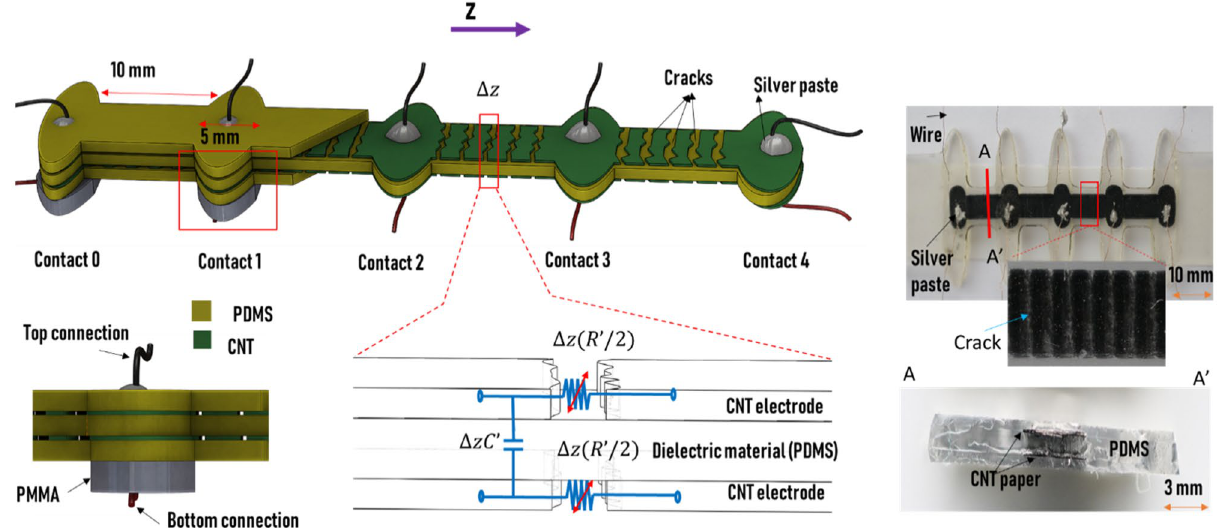
Figure 1. (Top left) Schematic representing the multilayer sensor (the electrical connections are distributed on the top and bottom electrodes at 10-mm intervals); (bottom left) cross-sectional view of an electrical contact section. The bottom of the flexible layers is affixed to a rigid support (PMMA) to ensure nonstretchable electrical connection zones (ellipsoidal breakers); (bottom center) electrical model of a small spatial segment (∆z), where R ′ and C ′ are the electrodes resistance and capacitance per unit length, respectively; (top right) photographs of the realized structure (with a zoomed-in image showing the cracks); (bottom right) cross-section photograph showing the different layers of the